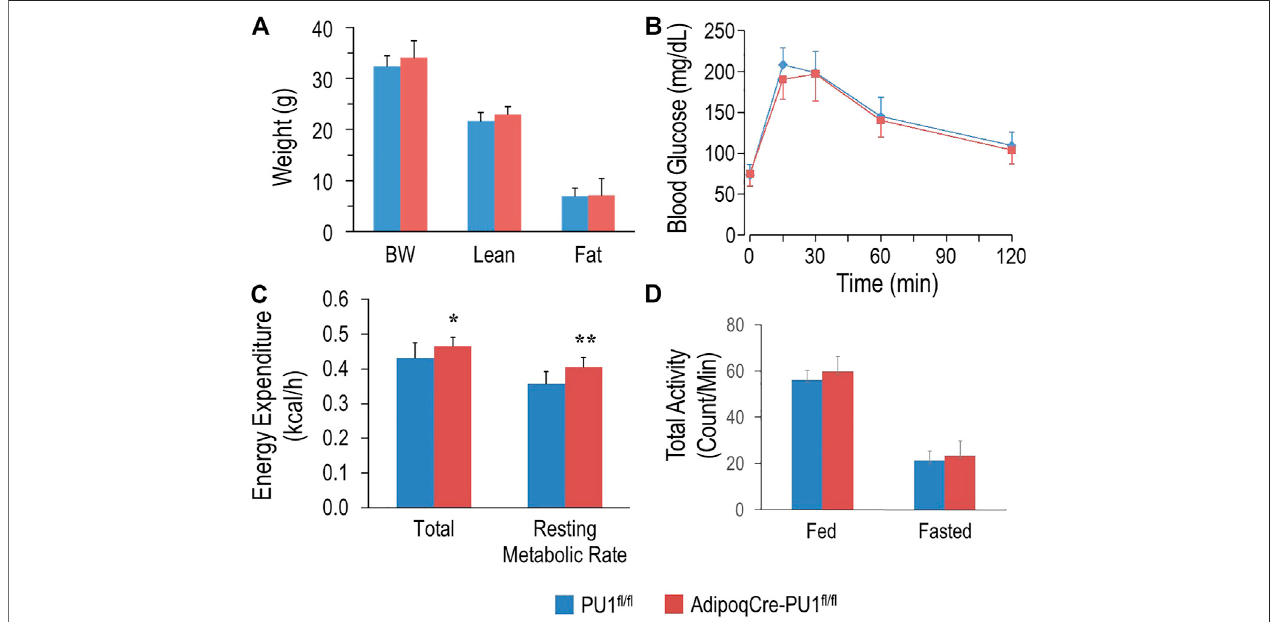
FIGURE2| AdipocytePU.1De fi ciencyHasNoEffectonBodyWeight,BodyCompositionandGlucoseToleranceinYoungAdultMaleMice. (A) Bodyweight(BW) and bodycompositionofyoungadult(4 – 5 monthsofage)male AdipoqCre-PU.1 fl / fl mice( N (cid:1) 8)and thecontrollittermatePU.1 fl / fl mice ( N (cid:1) 8). (B) Forglucosetolerance test, mice ( N (cid:1) 8 vs. 8) were fasted overnight and injected with glucose. Blood glucose was then measured. (C) Energy expenditure was determined using indirect calorimetryinthe integratedComprehensiveLab AnimalMonitoringSystem(CLAMS;Columbus Instruments) in4 – 5 monthsold male AdipoqCre-PU.1 fl / fl mice( N (cid:1) 8) and the control littermate PU.1 fl / fl mice ( N (cid:1) 8). (D) Total locomotor activity under fed or fasting condition. * p < 0.05, ** p < 0.01.